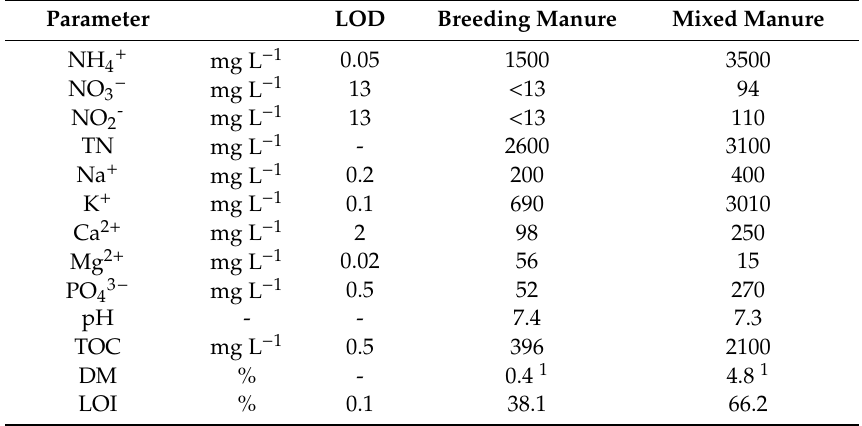
Table 1. Composition of breeding and mixed manure used in this study (LOD: limit of detection; TN: total nitrogen; TOC: total organic carbon; DM: dry matter; LOI: loss on ignition). Parameter LOD Breeding Manure Mixed Manure NH 4 + mg L −